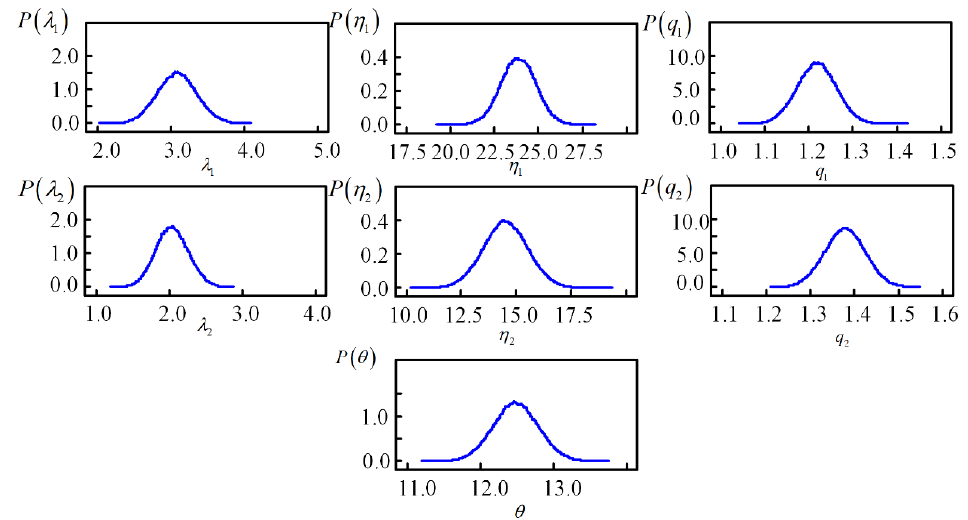
Figure 4. Posterior distributions for parameters in Model 5.